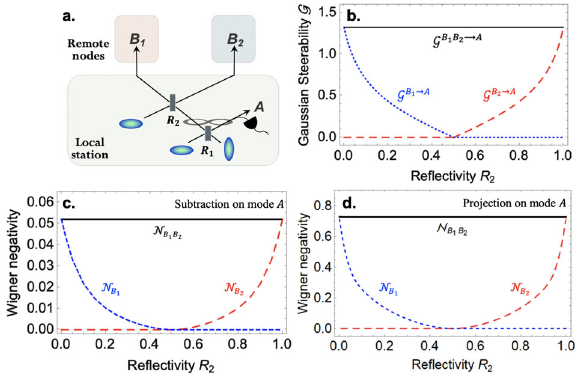
Fig. 2 Remotely generated Wigner negativity and initial Gaussian steering in a tripartite scenario. a A feasible linear optical network to remotely generate Wigner negativity: the local station produces a pure three-mode Gaussian state, then sends two outputs B 1 and B 2 to remote nodes. By performing some appropriate local operations on mode A , one can successfully prepare mode B 1 , or B 2 , or their joint ( B 1 B 2 ) to a Wigner-negative state. b Fixing R 1 : (1 − R 1 ) = 50: 50 and input squeezing levels r = 1 (corresponding to − 8.7 dB quadrature noise), the initial Gaussian steerability changes with a variable R 2 . c After a single-photon subtraction on mode A , the remotely generated Wigner negativity of mode B 1 , mode B 2 , and the group ( B 1 B 2 ), respectively. d After a photon-number-resolving measurement with two photons in mode A , the remotely generated Wigner negativity of mode B 1 , mode B 2 , and the group ( B 1 B 2 ),